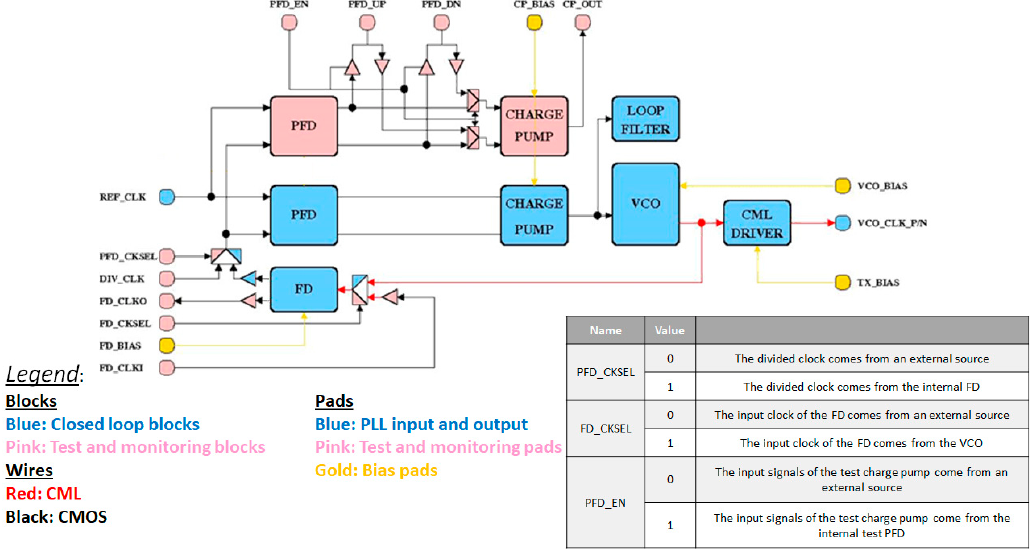
Figure 22. Block schematic of the test chip.